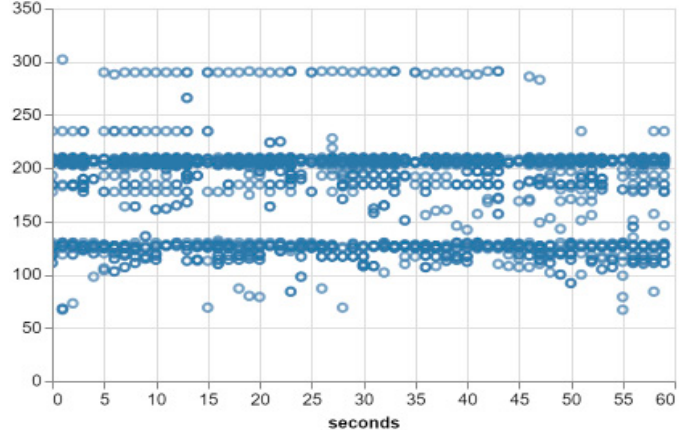
Figure 8. Scatter plot of the final dataset for the tested model category.